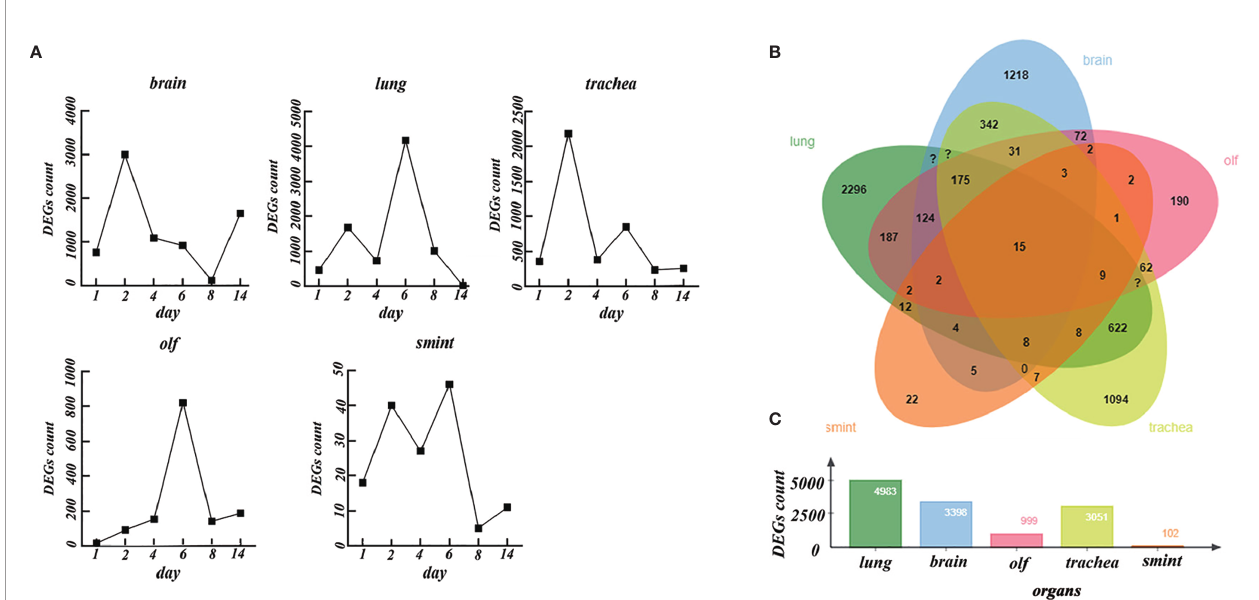
FIGURE 2 | The differentially expressed genes (DEGs) in different organs over time. (A) The number of DEGs in the brain, lung, trachea, olf, and smint over time. (B) Venn diagrams of DEGs in the brain, lung, trachea, olf, and smint. (C) The value of total DEGs in each